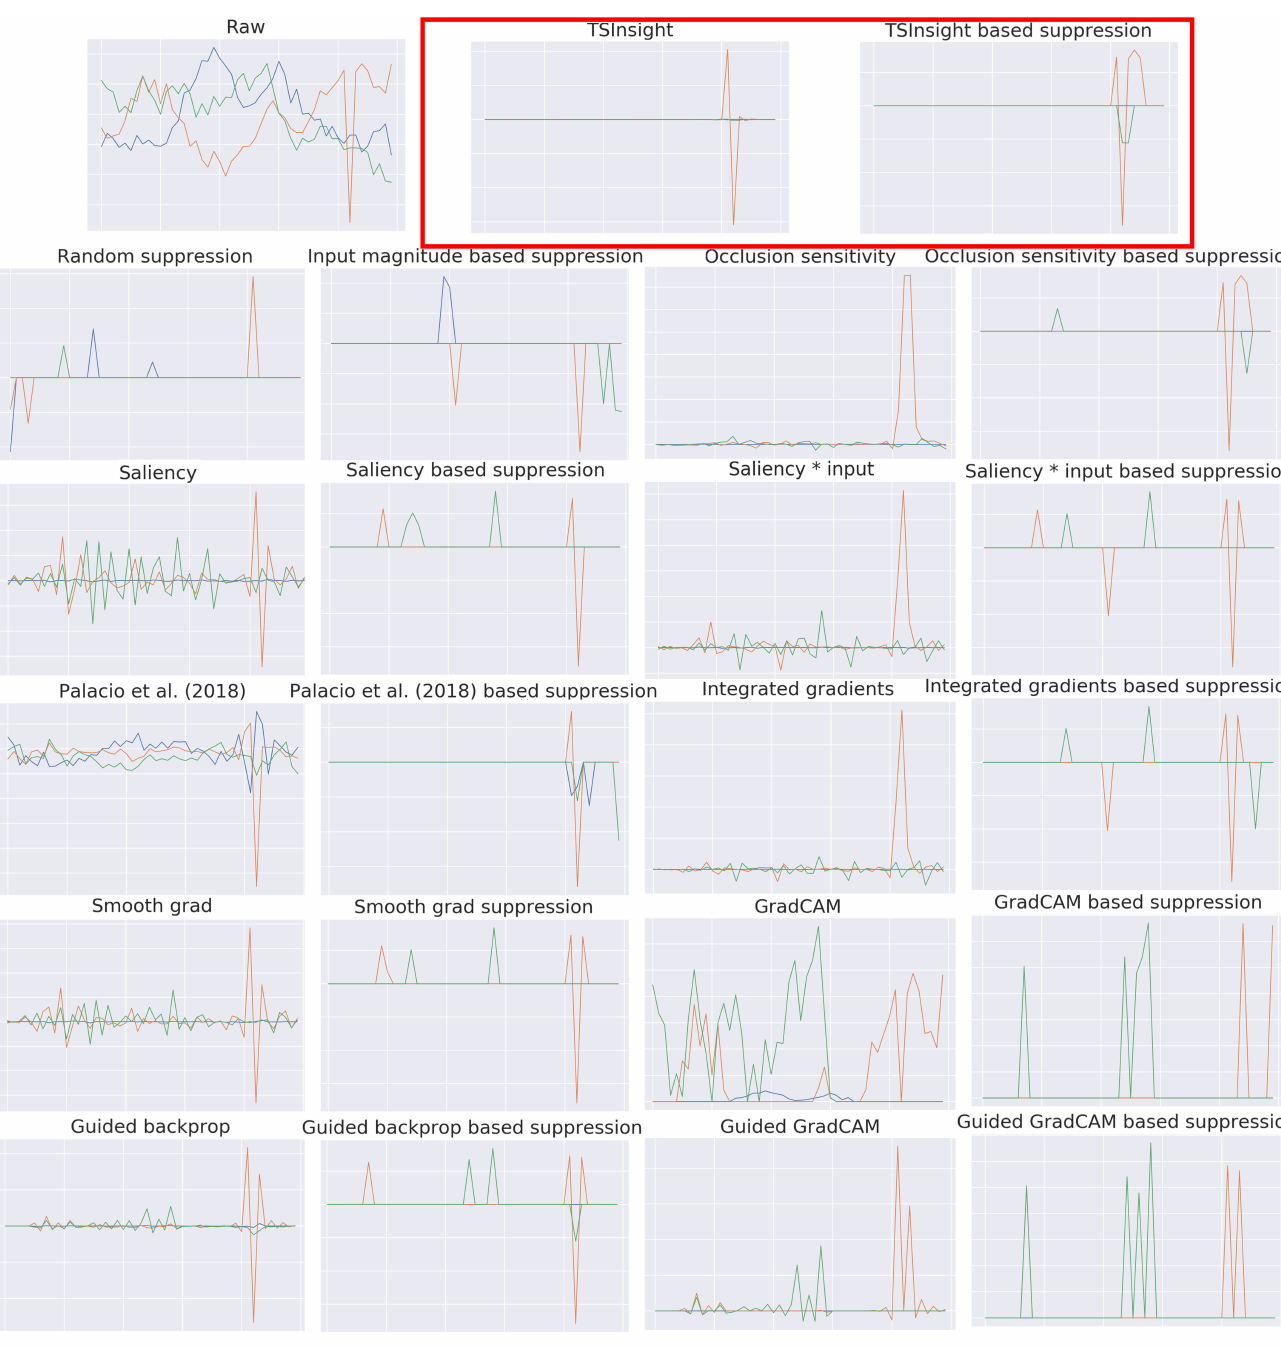
Figure 5. Output from different attribution methods as well as the input after suppressing all the points except the top 5% highlighted by the corresponding attribution method on an anomalous example from the synthetic anomaly detection dataset (best viewed digitally). All methods were able to correctly identify the anomalous spike given the simplicity of this dataset. However, qualitative differences exist between different